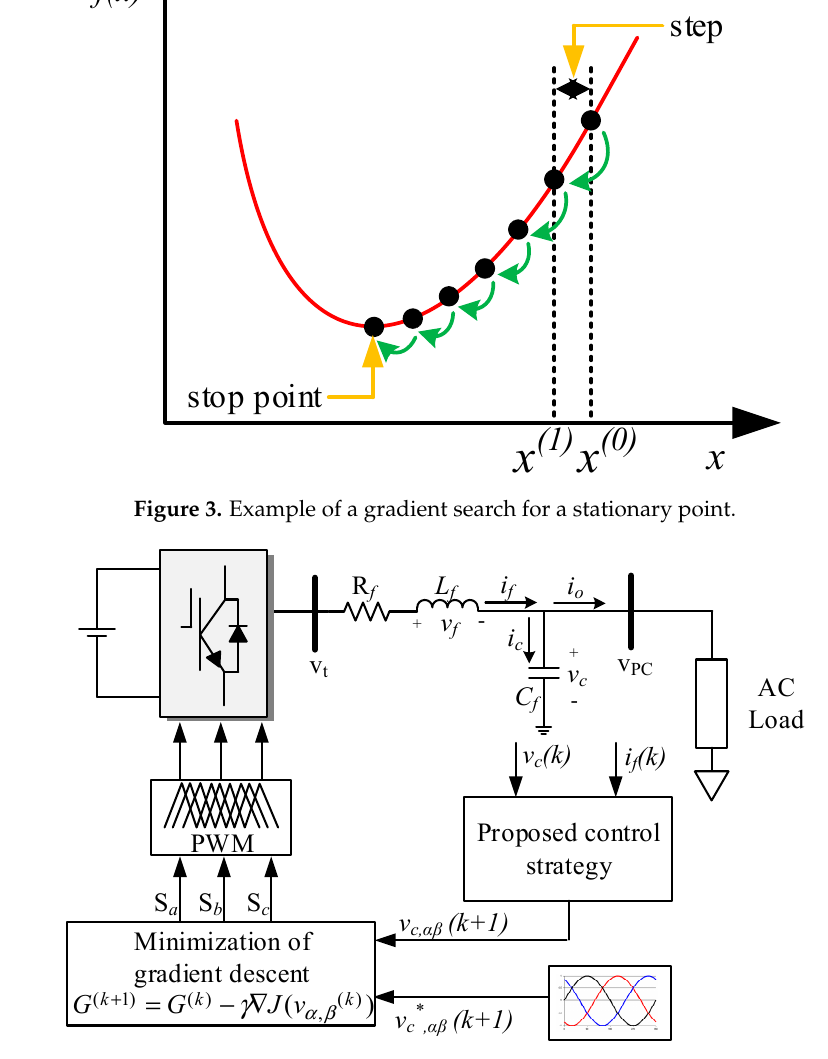
− ∇ Figure 5. Flowchart of the proposed control strategy. 4. Simulation Results